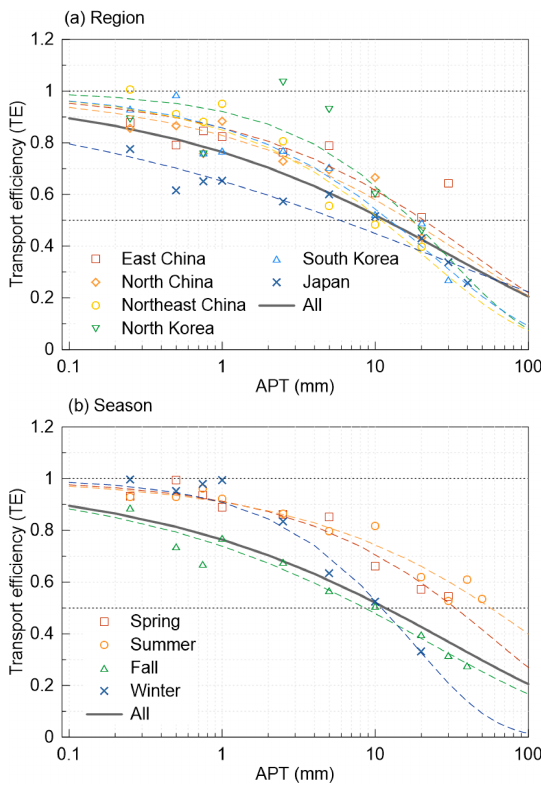
Figure 4. Same as Fig. 2 except for (a) regional and (b) seasonal variations in TE according to APT. Each colored symbol and dashed line indicates the different regions and seasons and fitting lines ac- cording to stretched exponential decay (SED). The thick gray line depicts the overall fitting line. The horizontal dotted lines indicate TE at 0.5 and 1,